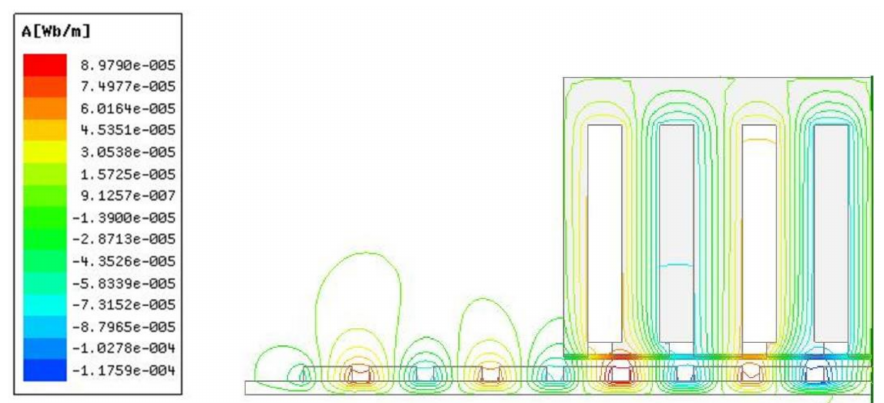
Figure 7. Magnetic field distribution of the TPMLG under no-load condition.